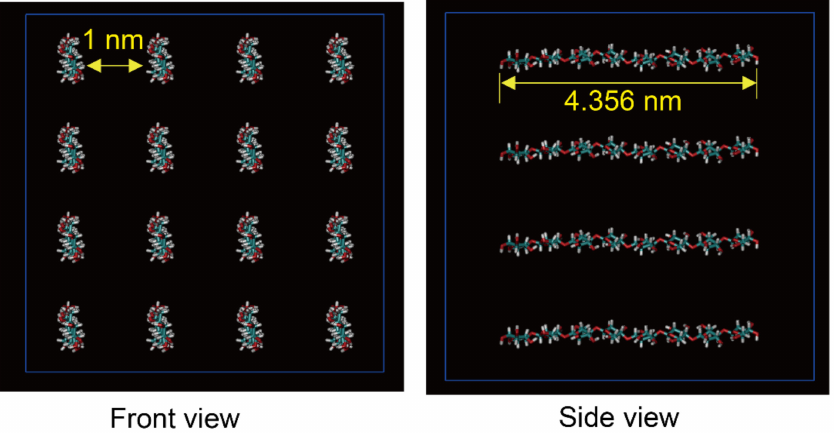
Figure 1. The initial configuration of cellulose (16 × 8) with 16 glucan chain system and a degree of polymerization (DP) =